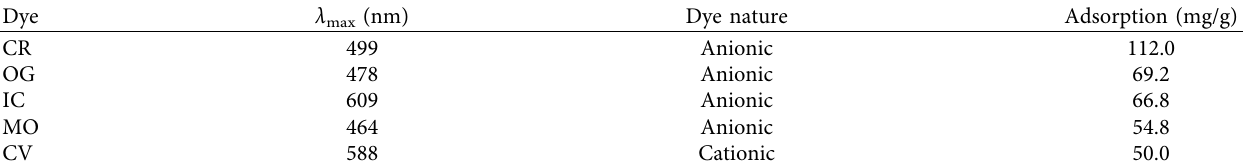
Table 1: Adsorption efficiency for different